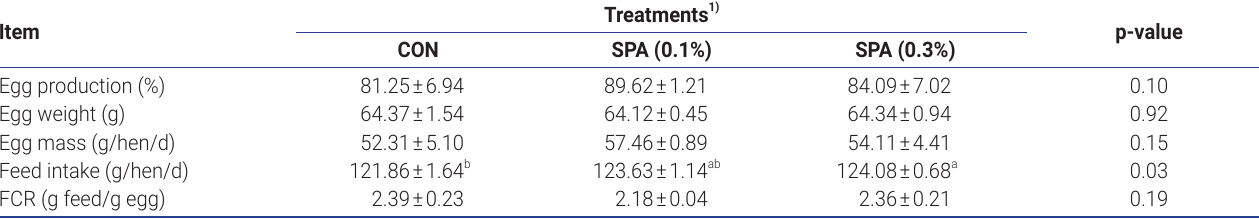
Values are means±standard error. SPA, fermented S. chinensis fruit pomace, fermented pine needle extract, and Chinese chive powder in the ratio of 2:2:1; FCR, feed conversion ratio. 1) CON, control, basal diet; SPA (0.1%), basal diet+0.1% SPA; SPA (0.3%), basal diet+0.3% SPA. a,b Means within a same row with different letters differ significantly at